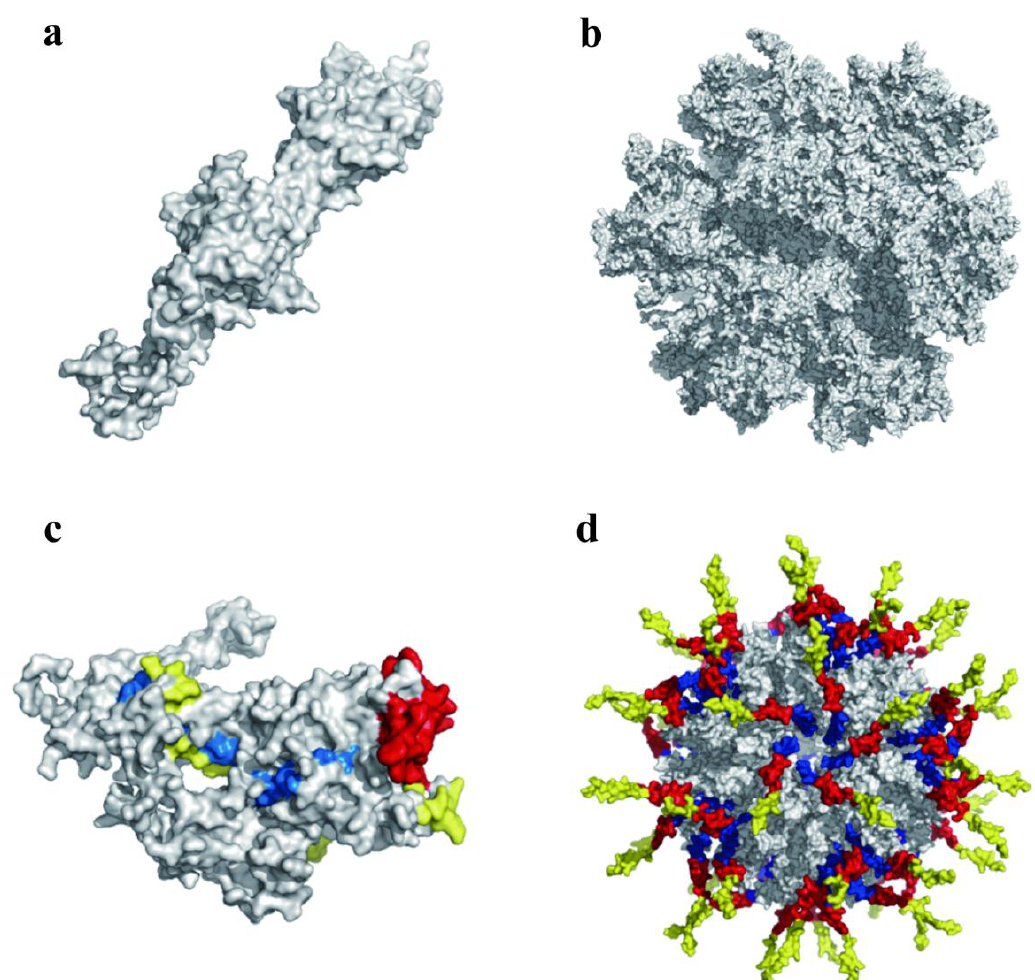
Figure 1. Three-dimensional structure displaying the recombinant ADDomer/ADDomer-RBT sub- unit and ADDomer/ADDomer-RBT VLP dodecahedron: ( a ) 3D structure of the recombinant AD- Domer VLP subunit; ( b ) 3D structure of the recombinant ADDomer VLP dodecahedron. ( c ) Three- dimensional structure of the recombinant ADDomer-RBT VLP subunit; ( d ) 3D structure of the recombinant ADDomer-RBT VLP dodecahedron. Colors yellow, blue, and red represent epitopes inserted in loops VL, RGD1, and RGD2, respectively.